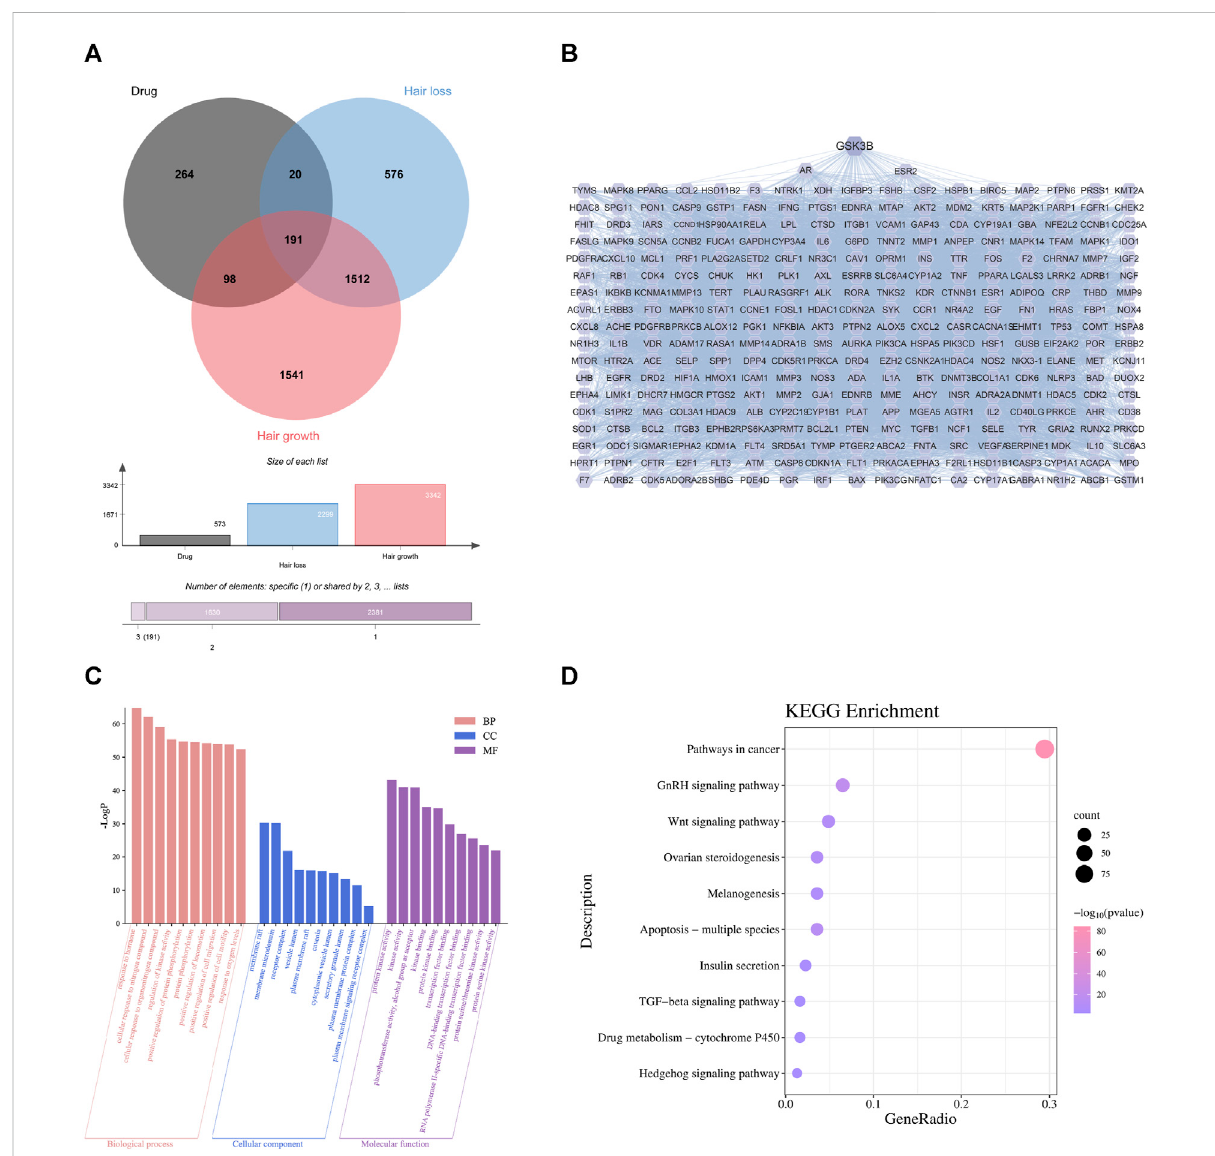
FIGURE 2 First-dimensional network constructed by putative bene fi cial components from TGD in alopecia. (A) Venn diagram of overlapping genes between putative bene fi cial components corresponding targets in TGD and alopecia targets. (B) PPI networks of common protein targets. (C) 10 pathwaysof BP, MF, and CC using GO enrichment analysis of intersection targets. (D) The bubble diagram of KEGG pathway enrichment